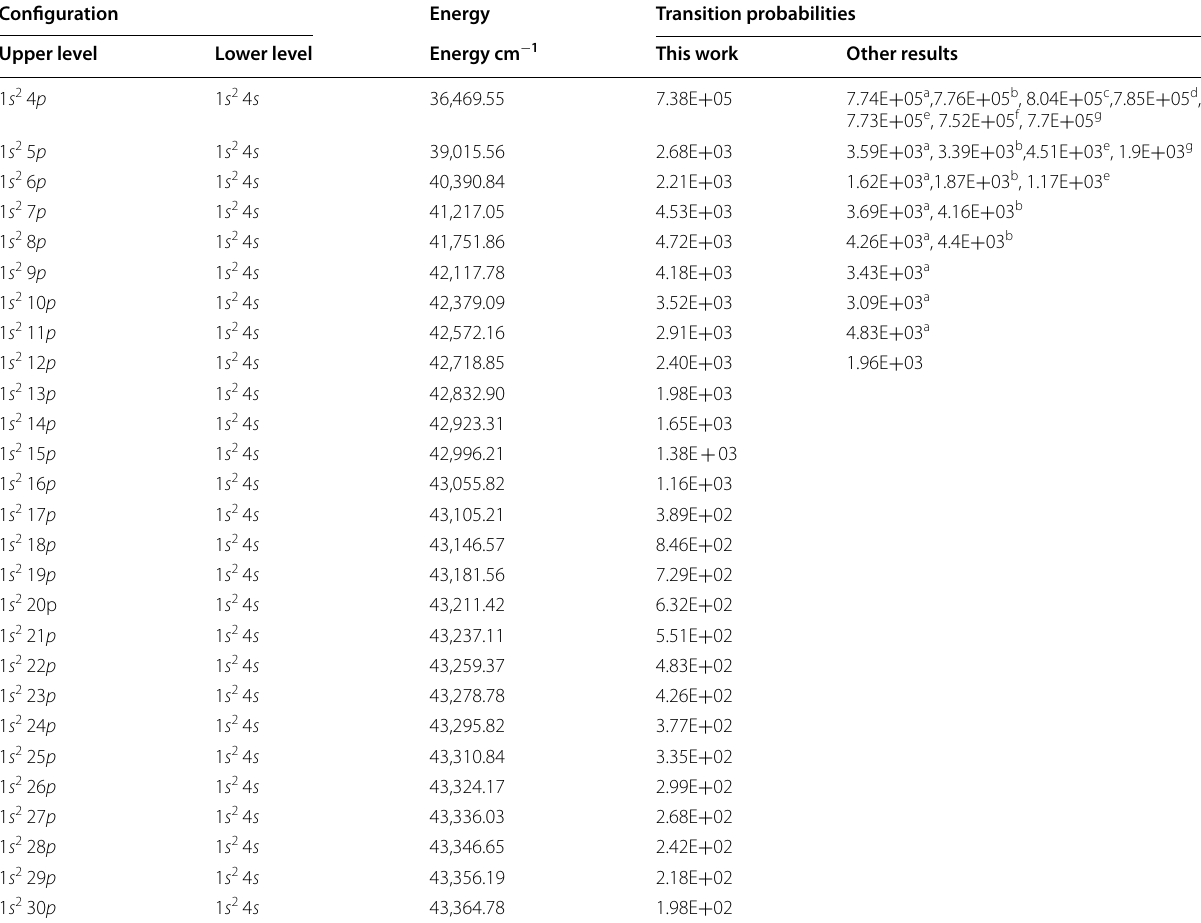
Table 3 Transition probabilities for the transitions 1 s 2 np –1 s 2 4 s calculated in this work compared with other